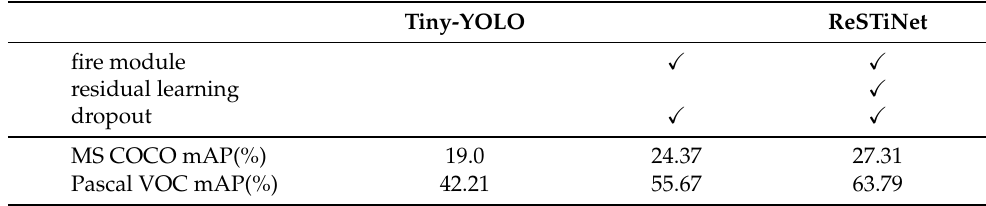
Table 3. Ablation experiments: Tiny-YOLO vs. ReSTiNet.